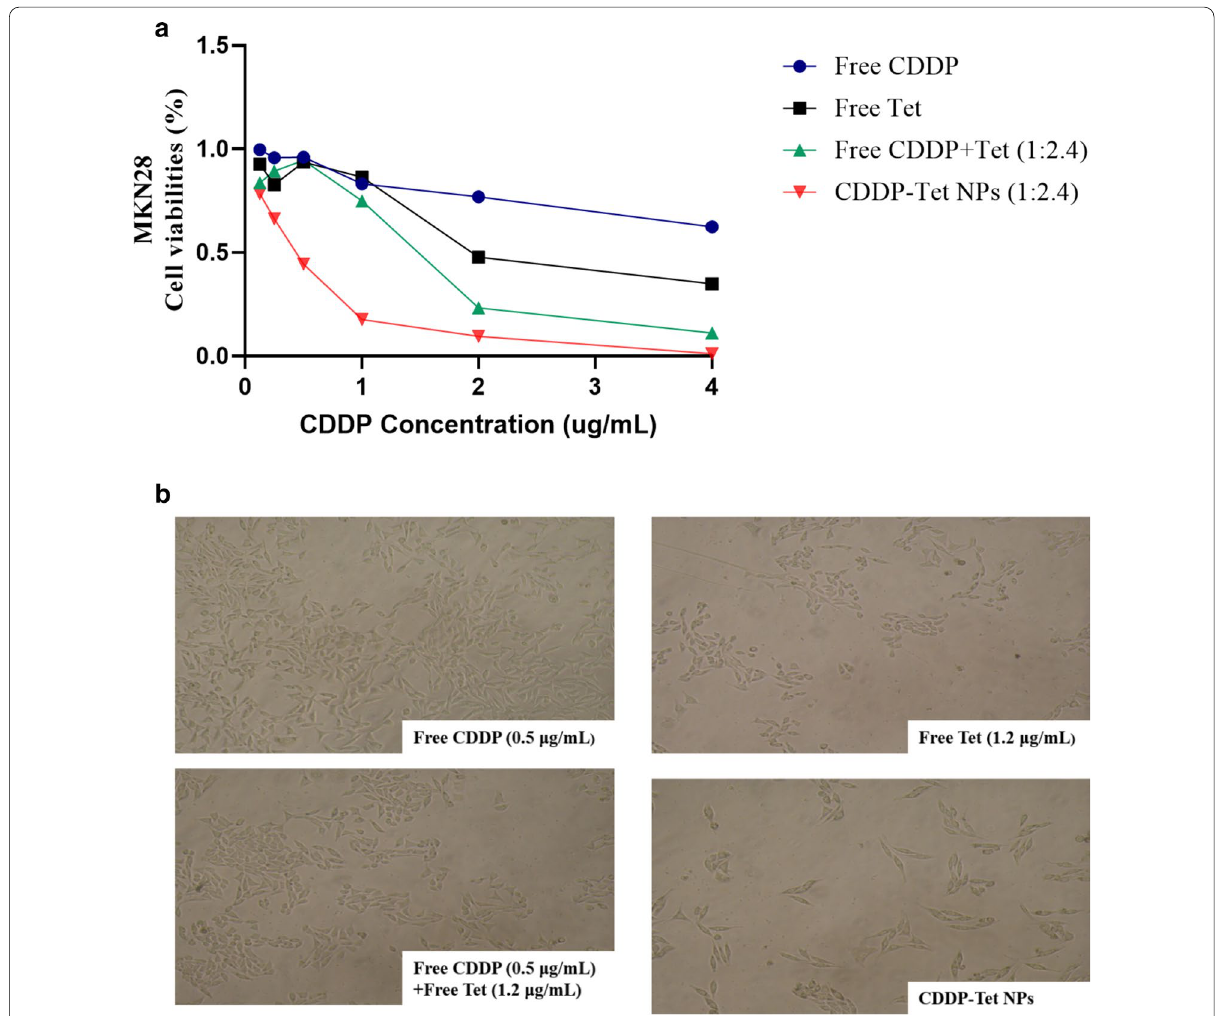
Fig. 3 In vitro cytotoxicity of the nanoparticles. a Cell viabilities of MKN28 after being co-cultured with drugs for 48 h. The concentration of Tet was 2.4 times as much as the concentration of CDDP. b Photographs of MKN28 cells under the light microscopy